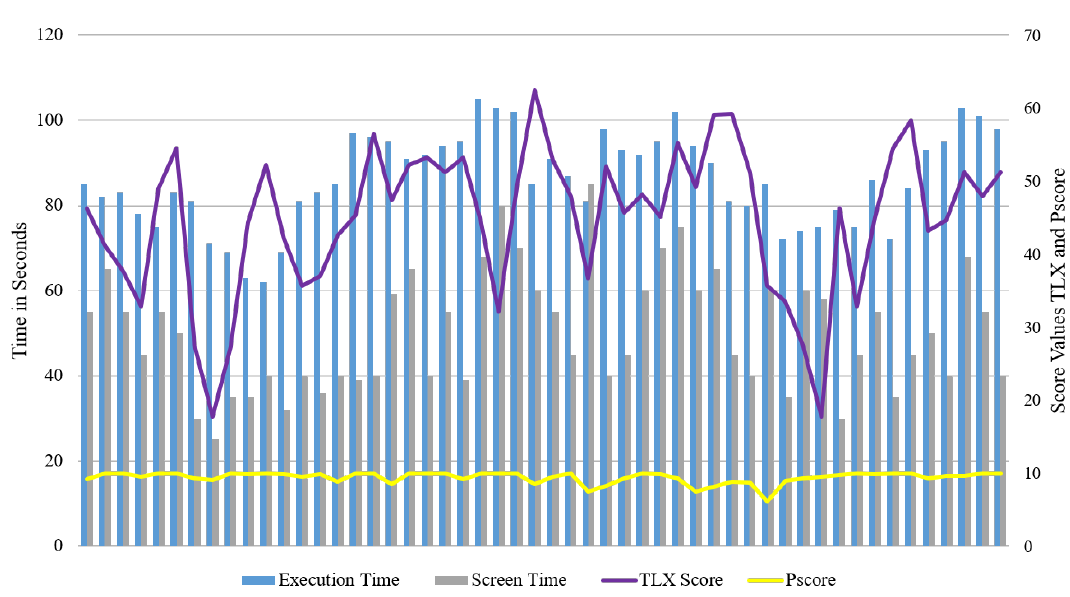
Figure 12. Screen time of all participants in comparison to execution time, TLX Score, and P-score of Trial